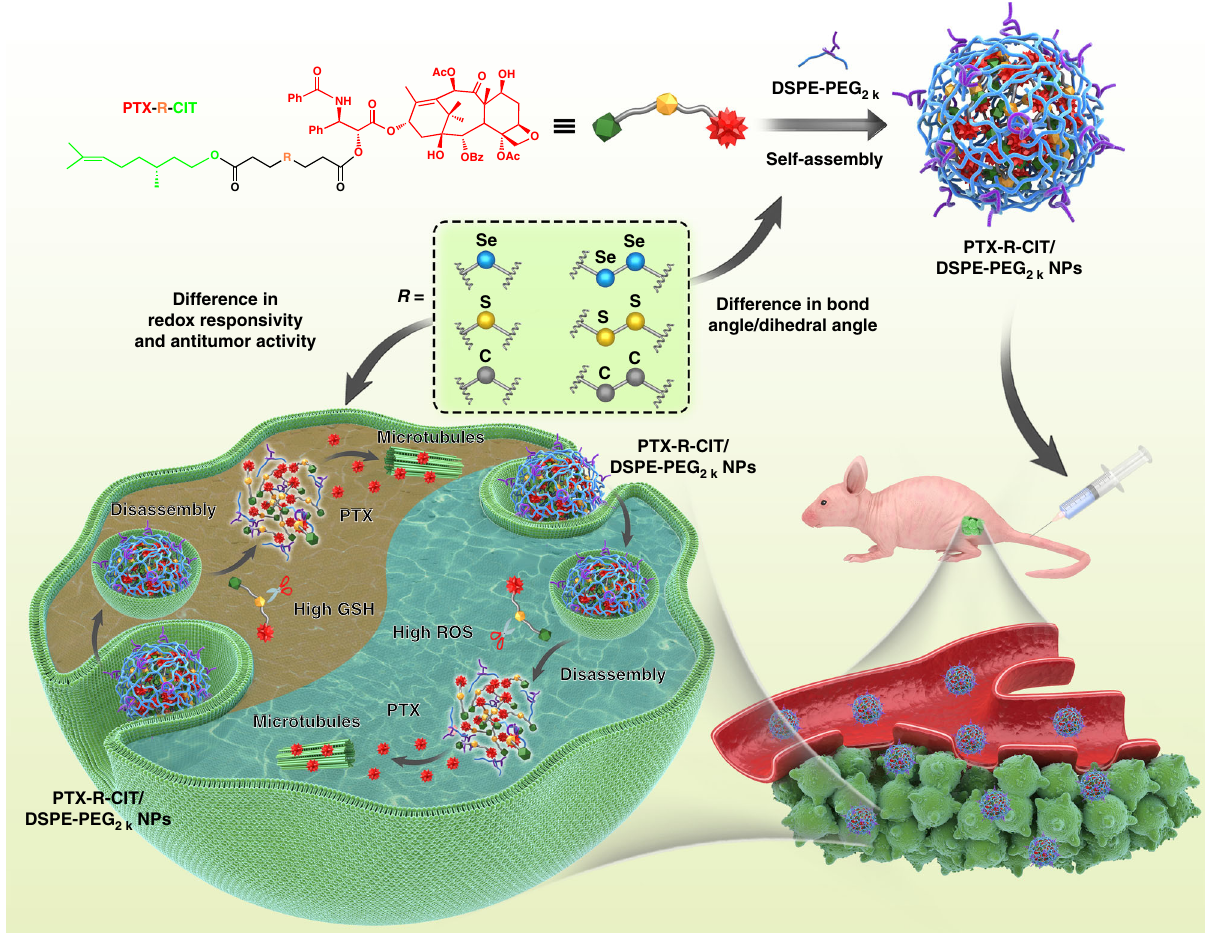
Fig. 1 Schematic representation. Sulfur/selenium/carbon bond-bridged PTX – CIT prodrug nanoassemblies for cancer